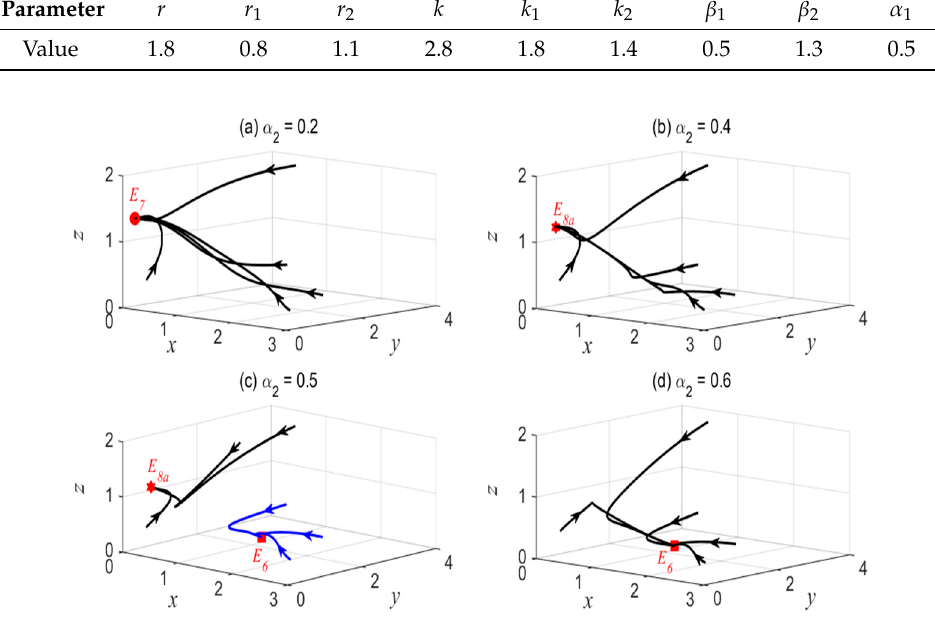
Figure 1. Phase portraits of model (2) for di ff erent value of competition rate of predator-2 ( α 2 ). ( a ) α 2 = 0.2, ( b ) α 2 = 0.4, ( c ) α 2 = 0.5, ( d ) α 2 = 0.6 .